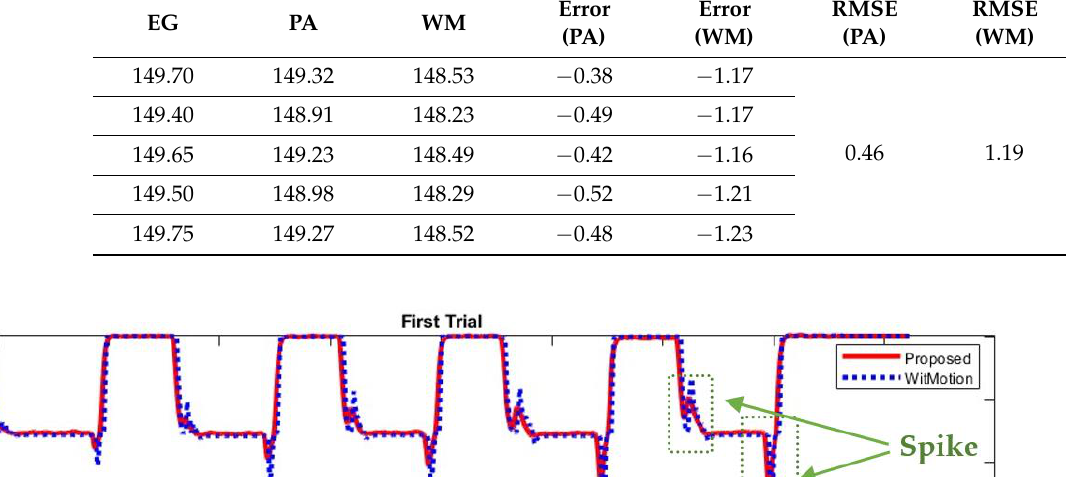
Figure 5. Joint angle (three sensors).